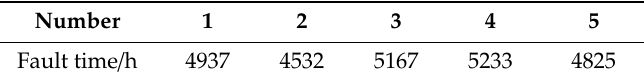
Table 1. Partial failure data of the